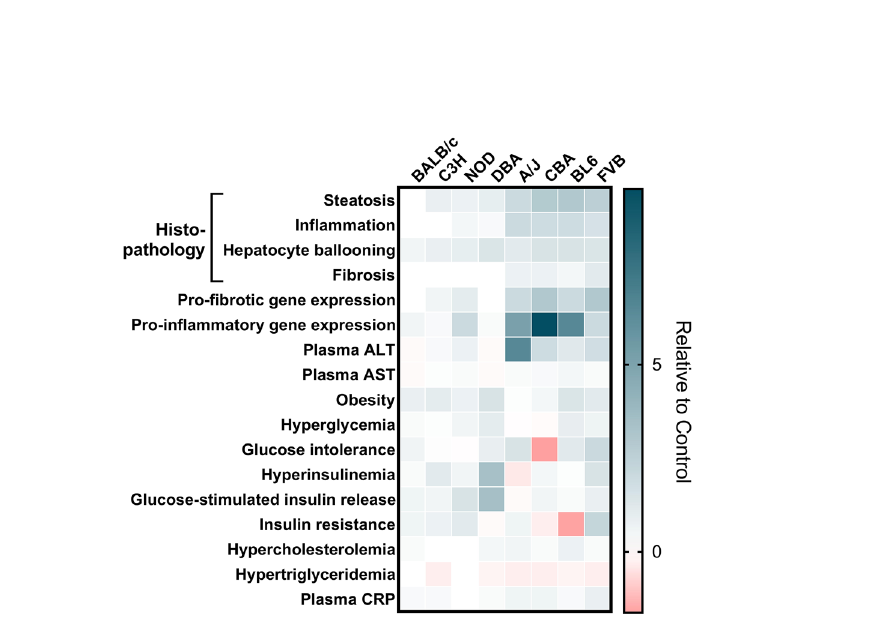
Figure 7. Summary heat map analysis highlighting the primary hepatic and metabolic changes observed in mice fed the NASH diet compared to their respective Controls, with all data points being relative and not representing actual values/data points. This heat map was considered for decision making of a ‘good’ NASH model. There was no formal weighting given to the criteria, with histological features of NASH as the primary consideration, then placing equal weighting on the metabolic comorbidities as a secondary consideration. For pro-fibrotic and pro-inflammatory gene expression, all variables measured through gene expression received equal weighting. Glucose intolerance is shown as total AUC, while insulin resistance is shown as glucose disappearance rate for the ITT